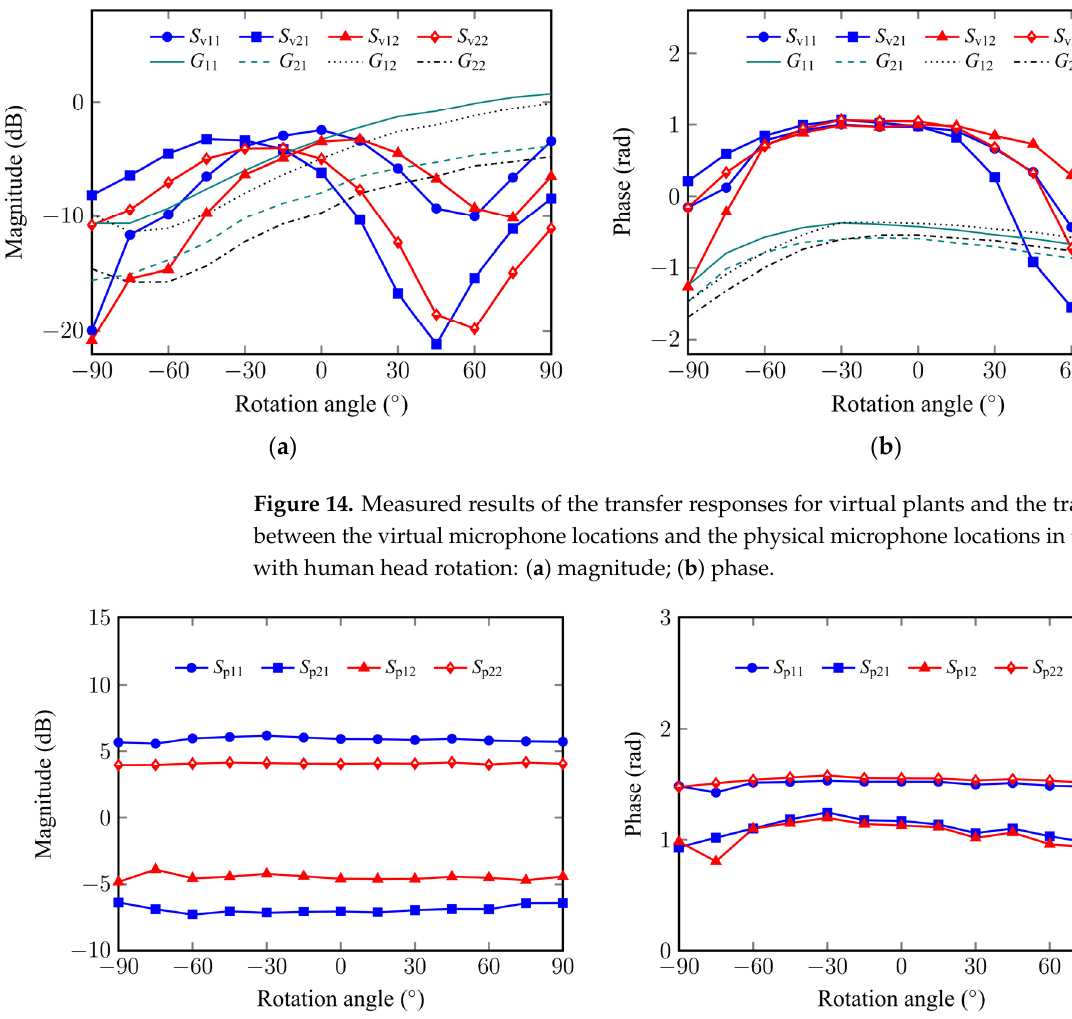
Figure 15. Measured results of the transfer responses for physical plants with human head rotation: ( a ) magnitude; ( b )